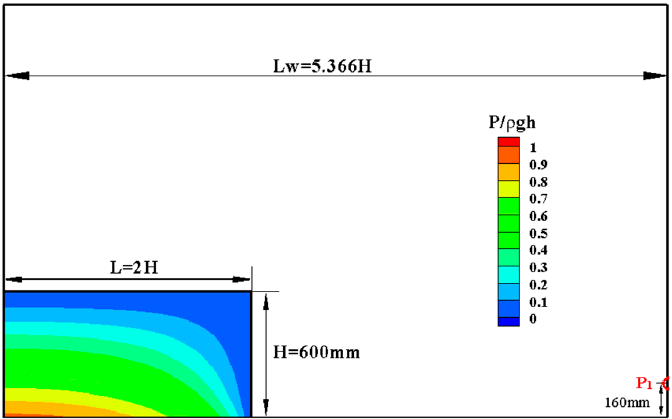
Figure 5. Sketch of the model of the dam-break flow against a vertical wall.